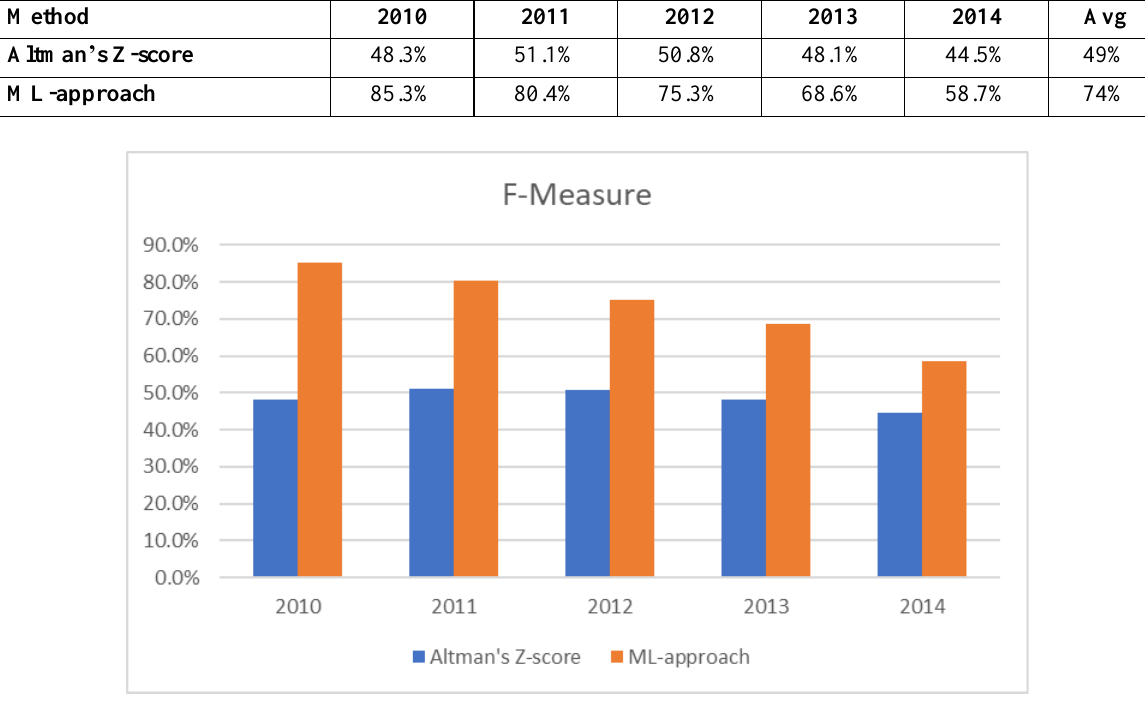
Figure 3. F-Measure: Altman’s Z-score VS